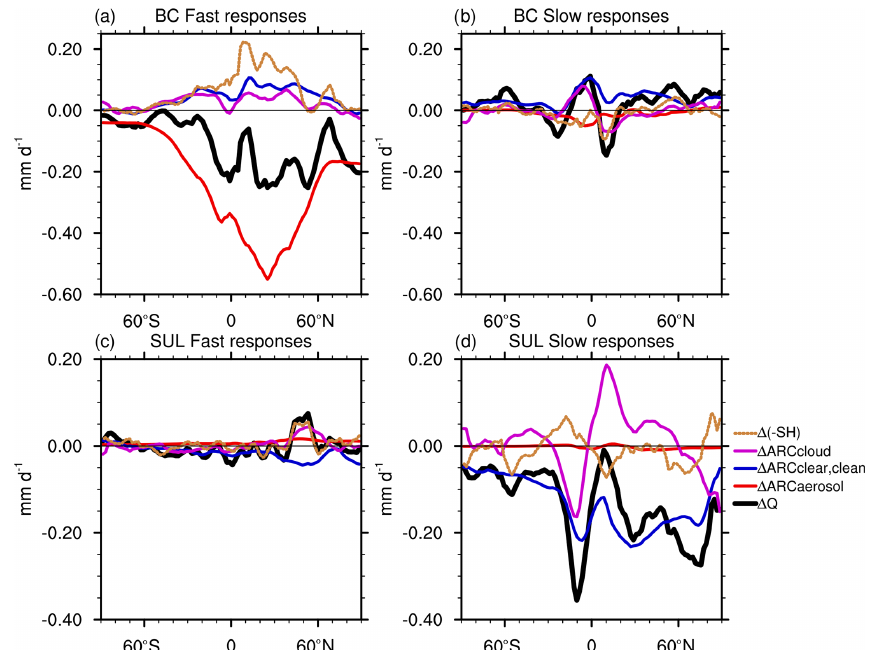
Figure 5. ECHAM6–HAM2 simulated multi-annual zonal mean of decomposed changes in atmospheric diabatic cooling ( (cid:49)Q ), including ARC changes from aerosols ( (cid:49) ARC aerosol ), clouds ( (cid:49) ARC cloud ), clear–clean sky ( (cid:49) ARC clear , clean ), and downward sensible heat flux ( (cid:49)( − SH ) ) for (a) fast responses in the BC case, (b) slow responses in the BC case, (c) fast responses in the SUL case, and (d) slow responses in the SUL case. All items are shown in equivalent precipitation units of mmd − 1